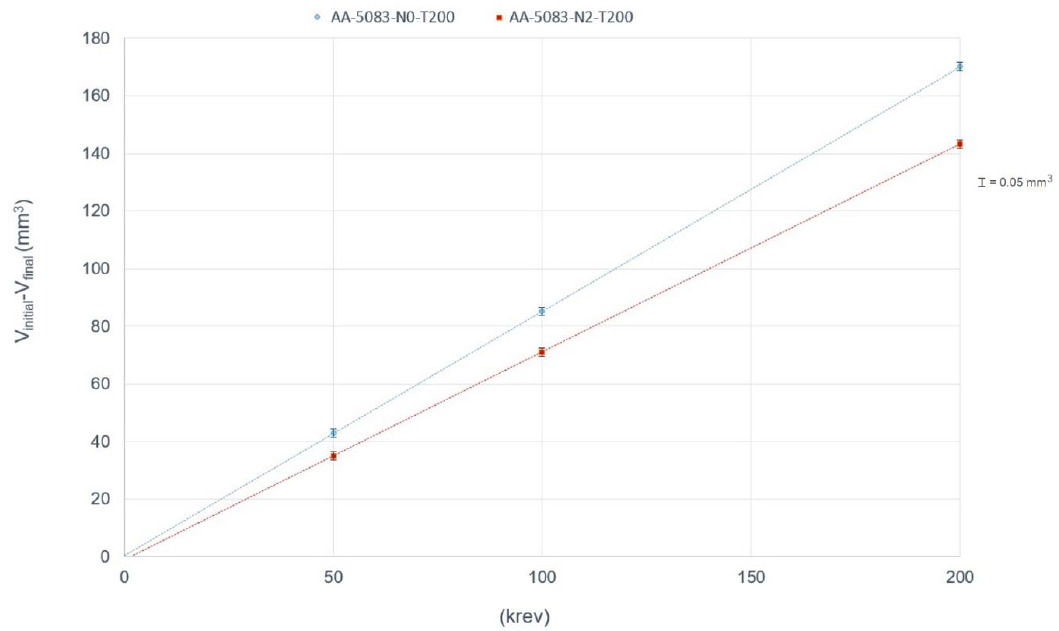
Figure 6. Wear versus revolutions for the isothermally-forged cams, where the scale for the uncertainty values has been amplified as indicated in order to be plotted more clearly.